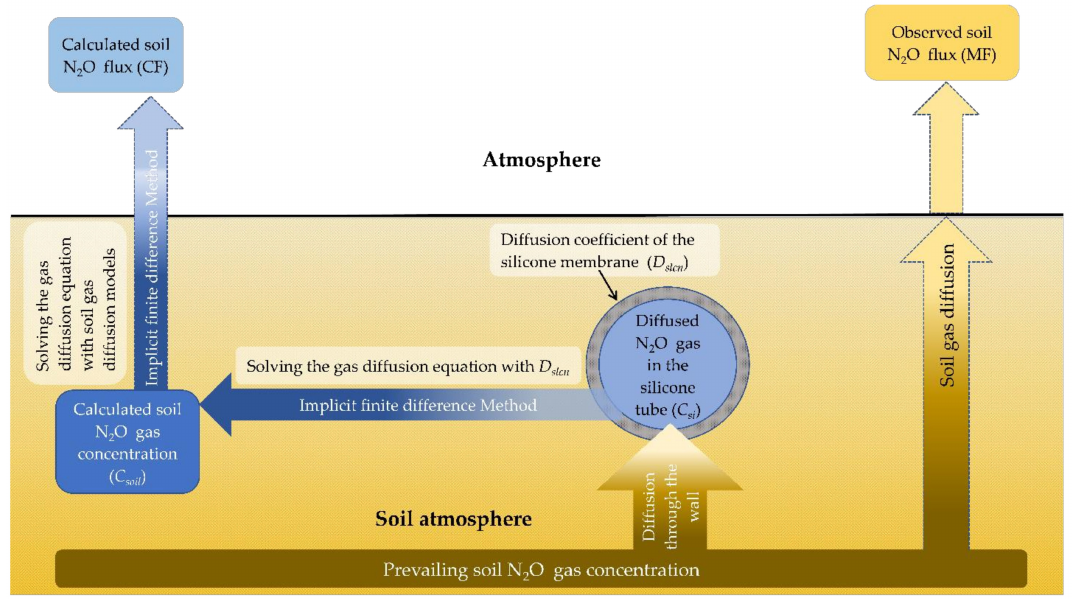
Figure 1. The main simulation steps for predicting the N 2 O flux from measured soil gas levels in the silicone diffusion